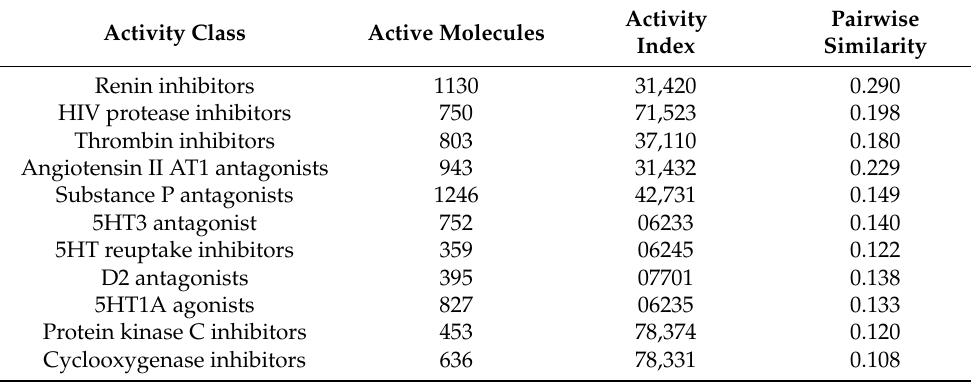
Table 1. The MDDR-DS1 structure activity classes.